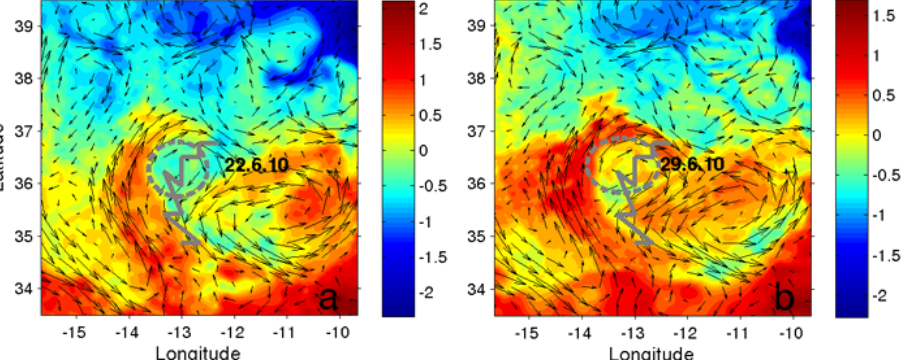
Fig. 6. Anomalies of SST ( ◦ C) around Meddy 1 (marked as the dashed circles) backtracked with surface vorticity on the 22nd (a) and 29th (b) of June 2010. Anomalies are computed by subtracting the mean value of SST over the presented area. AVISO altimetry currents are overlaid. Thick grey lines mark the meddy track and black circles show the extension of the associated negative anomalies of relative vorticity for the dates presented.